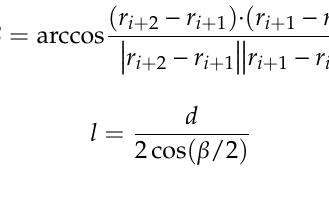
Figure 5. Preprocessing schematic diagram.